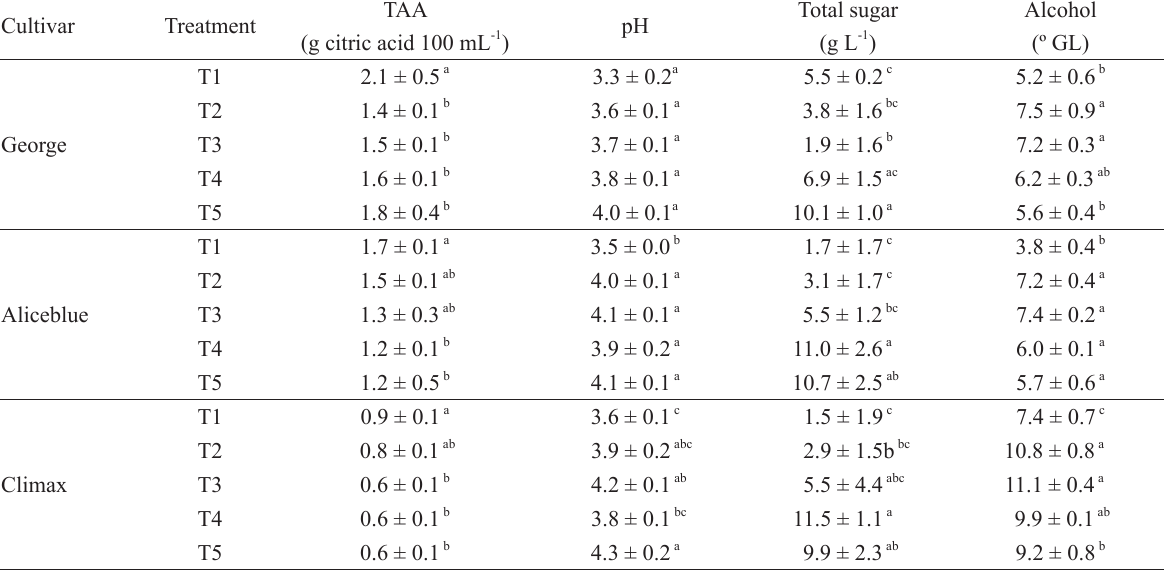
Physicochemical analysis of blueberry